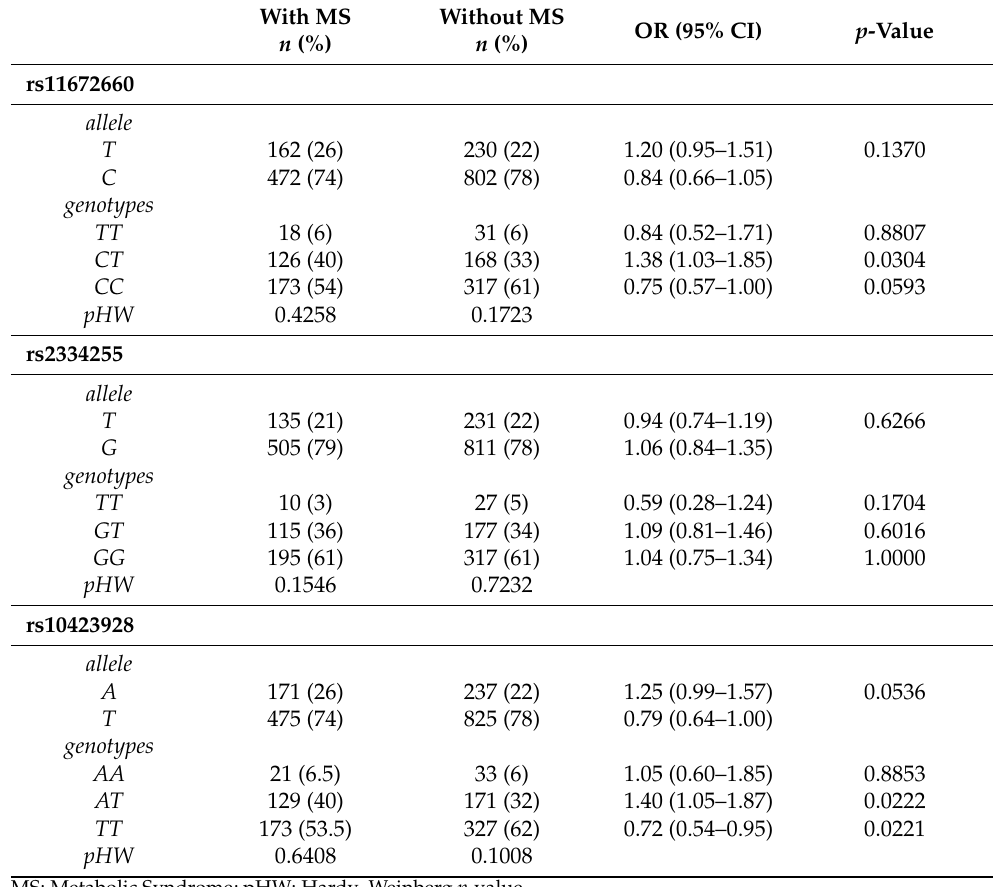
Table 3. The genotype distribution of rs11672660, rs2334255 and rs10423928 in the subjects with and without metabolic syndrome.